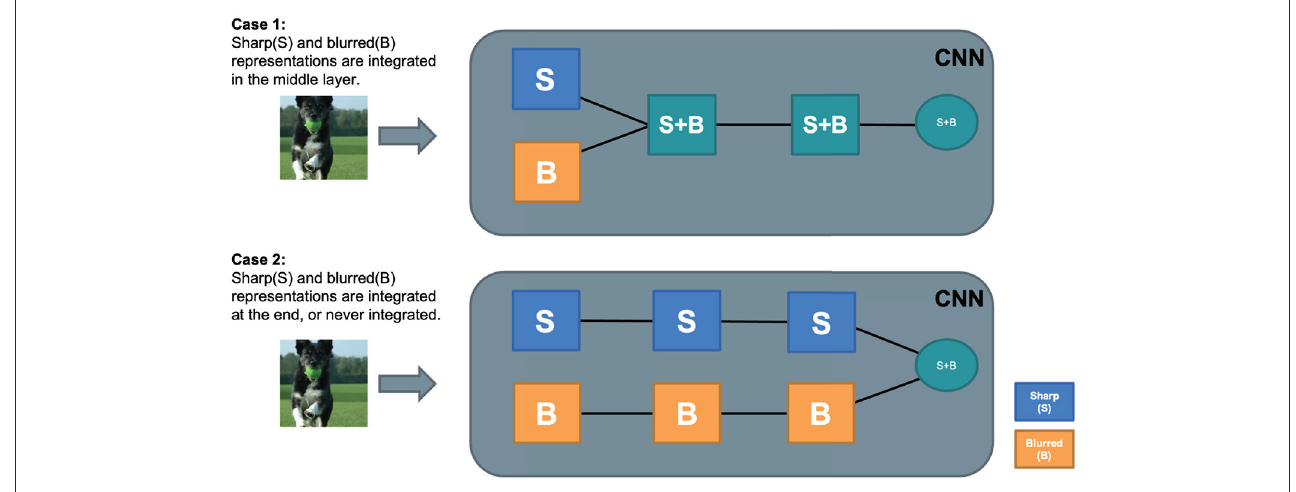
FIGURE4 Two hypotheses about intermediate feature representation of B+S net. Case 1 is more efficient and presumably close to human